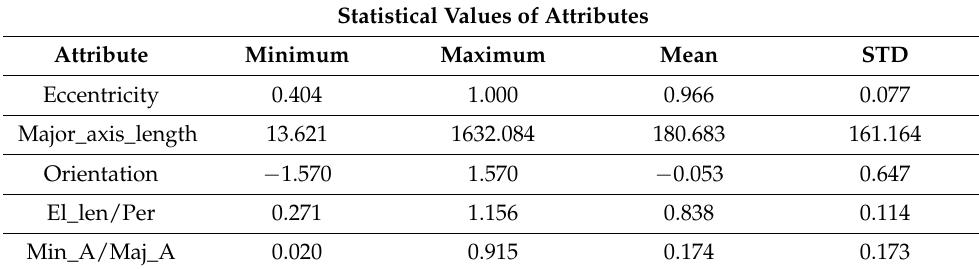
Table 5. Statistical parameters of attribute distributions.